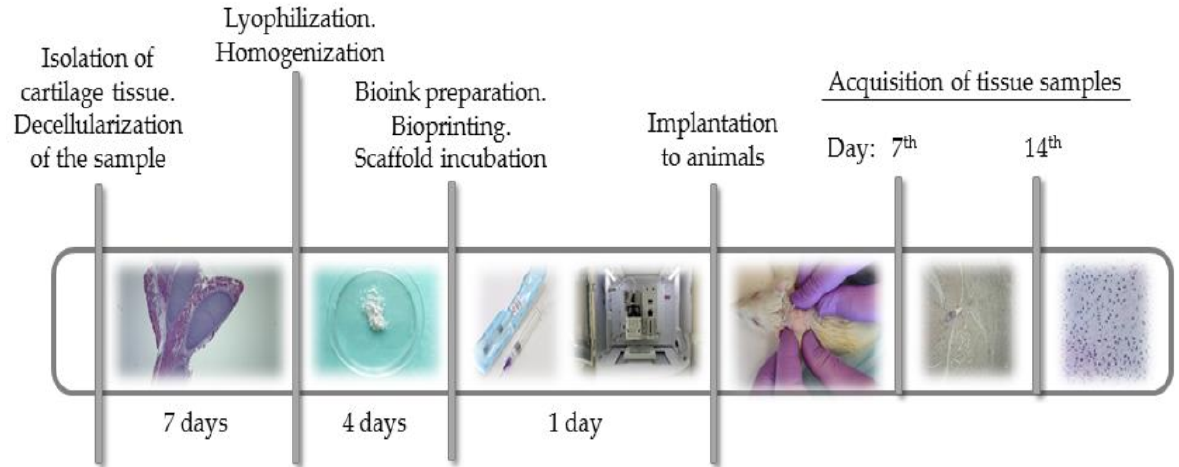
Figure 1. Study design. dECM powder was obtained from rat costal cartilage by decellularization, lyophilization and milling. Bioink containing sterile type I pig atelocollagen, dECM powder and human MSC were used to print scaffolds. The scaffolds were implanted under the skin in the withers area in 12 rats. The histological and immunohistochemical studies of material from animals was done on days 7 and 14 after